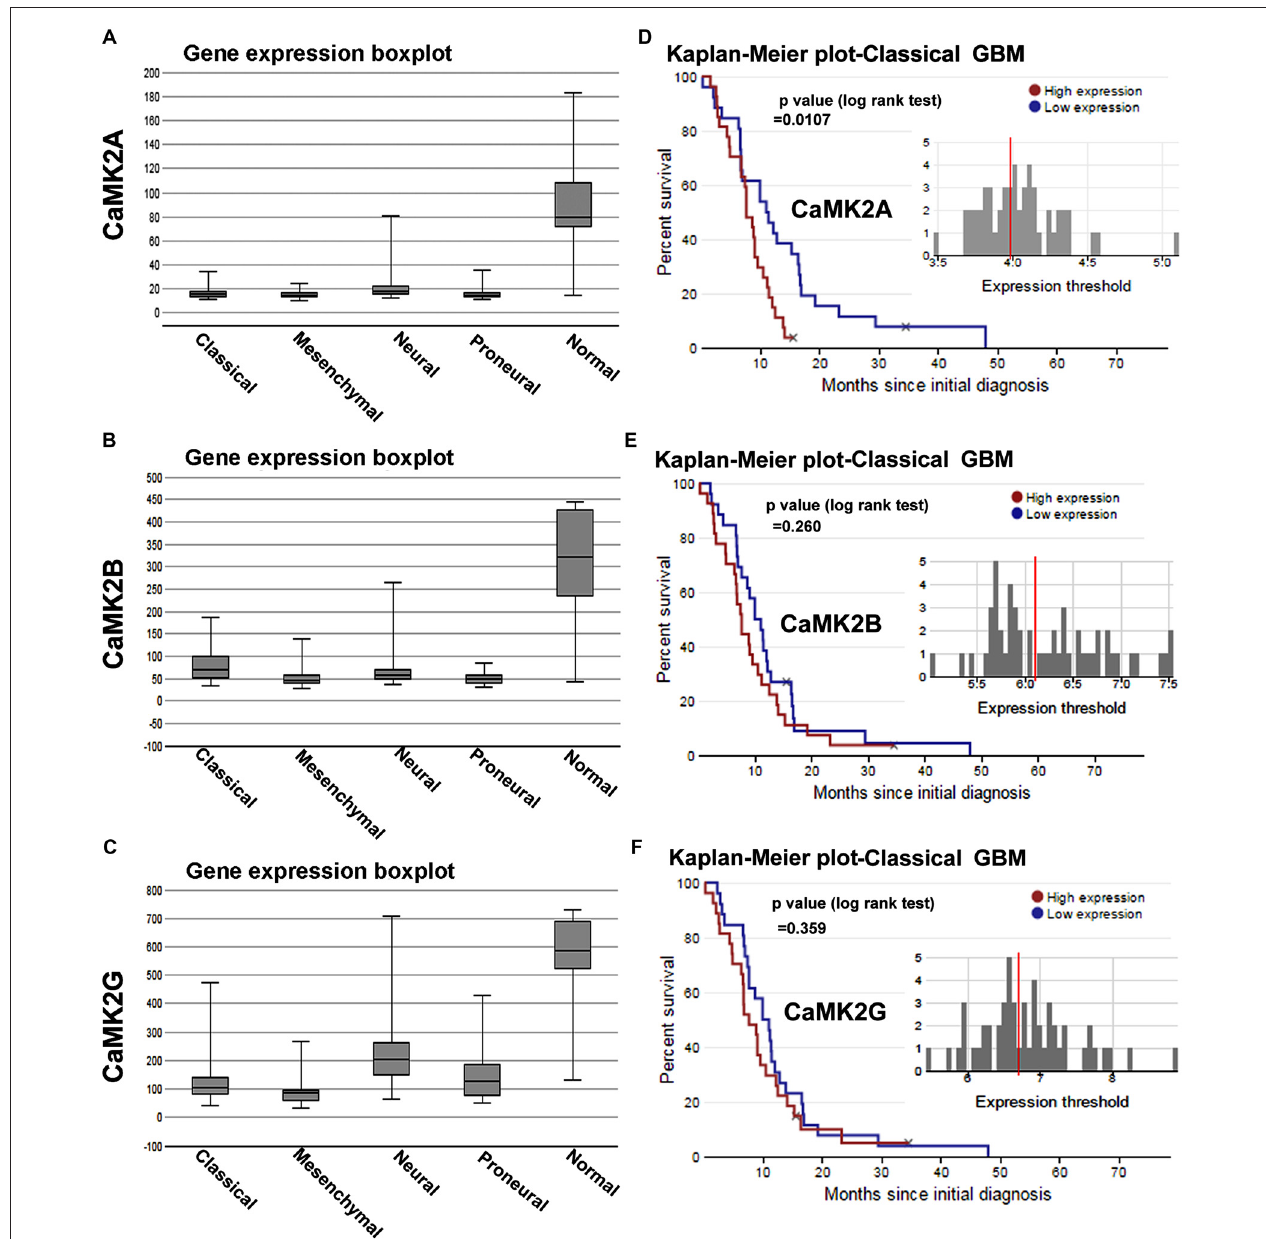
FIGURE 1 | Calcium/calmodulin-dependent protein kinase II (CaMKII) gene expression and survival curves are associated with lower survival rates in glioblastoma multiforme (GBM) patient sub-types. (A–C) shows The Cancer Genome Atlas (TCGA) data based comparative gene expression profiles of CaMK2A, 2B and 2G isoforms of CaMK2 enzyme in normal and glioblastoma patients, sub-classified into classical, mesenchymal, neural and proneural GBMs. Data revealed that all isoforms of CaMK2 are expressed at a lower levels in GBM than in normal controls. CaMK2G gene expression was highest in all subtypes in comparison to other isoforms. (D–F) respectively shows CaMK2A, 2B and 2G associated Median Survival Curve analysis using glioblastoma patient data in TCGA data set under classical (most predominant) GBM subtype. Observations revealed that CaMK2A expression alone was significantly associated with poor prognosis [median survival, 15 months in CaMK2A high group (red) vs. 48 months in CaMK2A low group (blue)]. See also Supplementary Figures S1, S2 and S3 for more details on expression and survival curves in other GBM subtypes. TCGA data was extracted from URL: